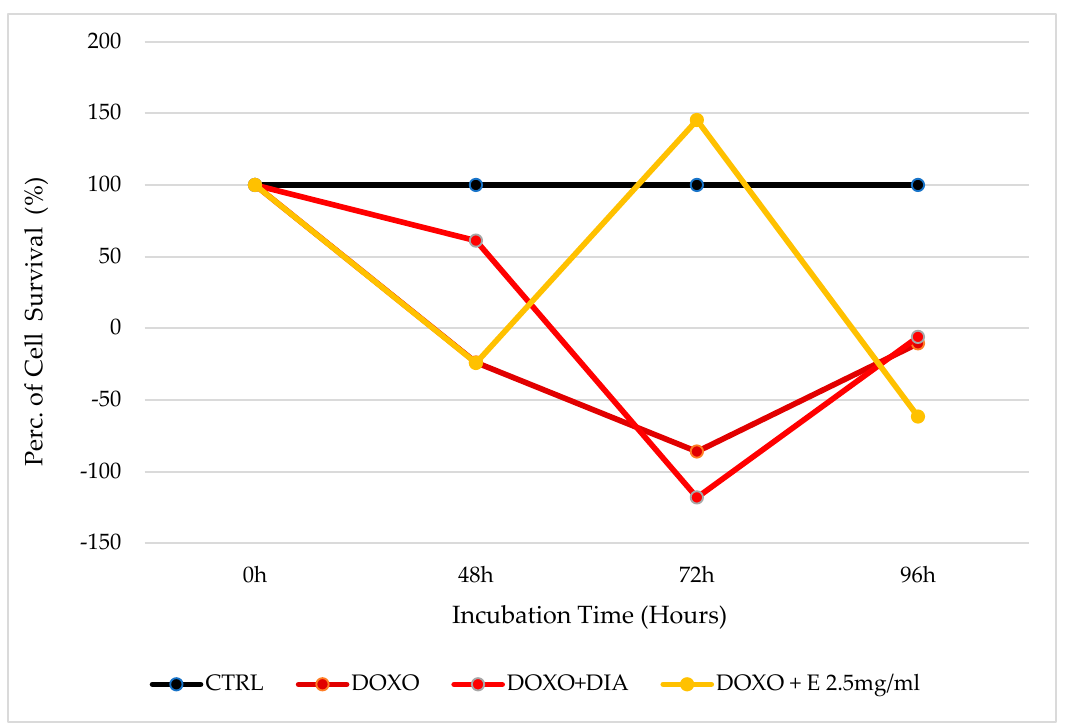
Figure 4. Percentage of cell growth values of bone marrow cells co-incubated with doxorubicin (DOXO) alone, doxorubicin and diazoxide (DIA), and doxorubicin and the extract (E) measured using the crystal violet assay, compared to control (CTRL). Data are shown for a 2.5 mg/mL concentration of the extract after 0 h, 48 h, 72 h, and 96 h of incubation. One-way ANOVA testing for differences between and within groups of treatments showed significant differences between treatments (F > 2.5 and p < 0.005) at different incubation times for DOXO and DOXO + E 2.5 after 72 h of incubation (N experiments = 6). The negative values in the figure were due to the calculation made relative to the percentage values of the number of cells in each well, which in turn were derived through the calibration curve obtained from a growth curve in the 96-well plates. Thus, when a negative number for the percentage of cell survival is obtained, this means that there is a very low absolute value.